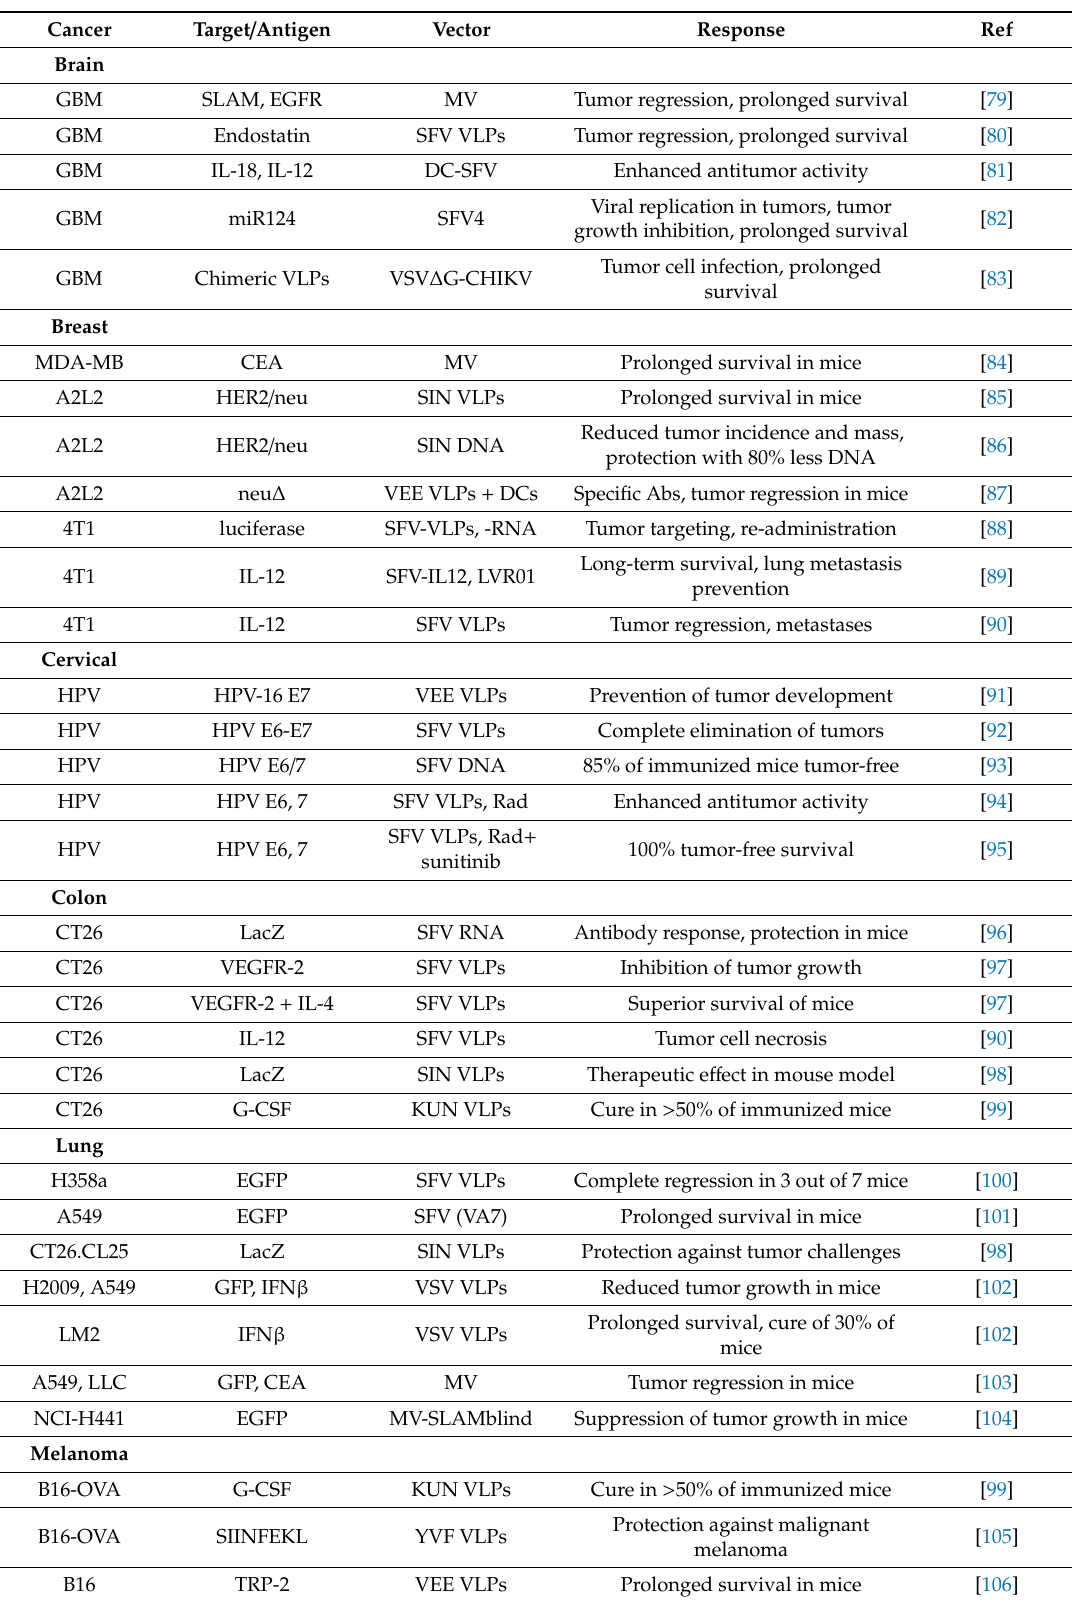
Table 2. Examples of preclinical immunizations targeting